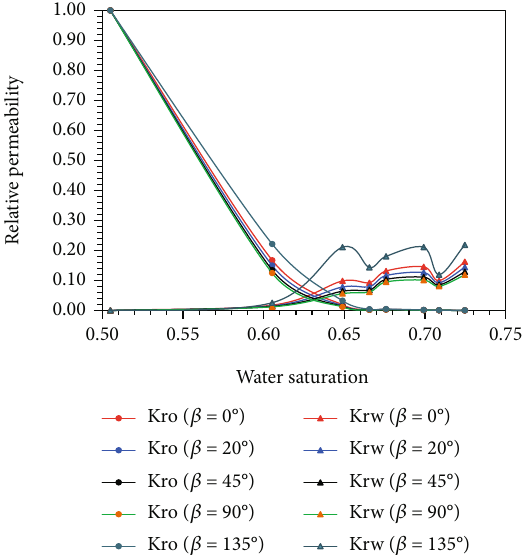
Figure 5: E ff ect of gravity on oil-water relative permeability.